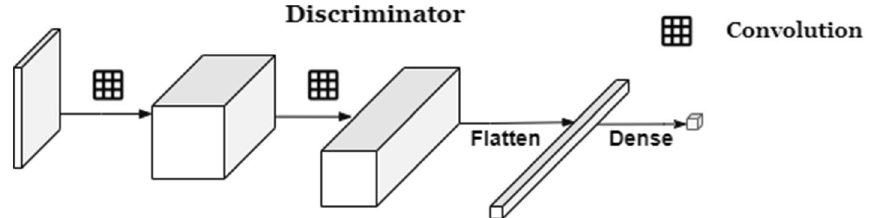
Figure 5. RANDGAN’s discriminator architecture.